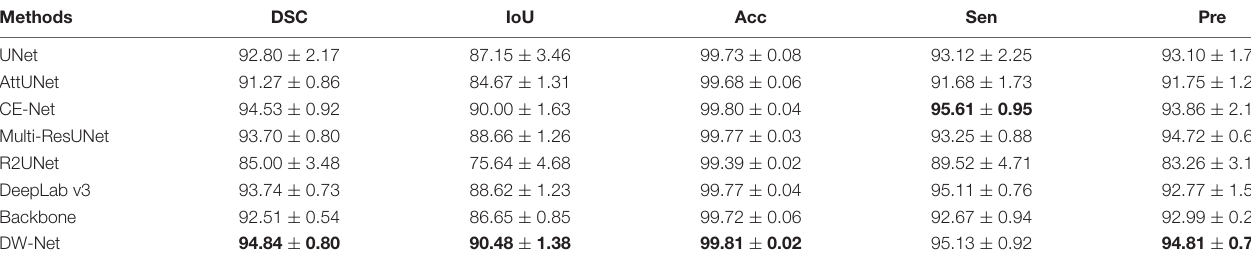
TABLE 2 | Choroid neovascularization (CNV) segmentation results (in percent) of the contrast experiments and ablation studies (mean ± SD). Methods